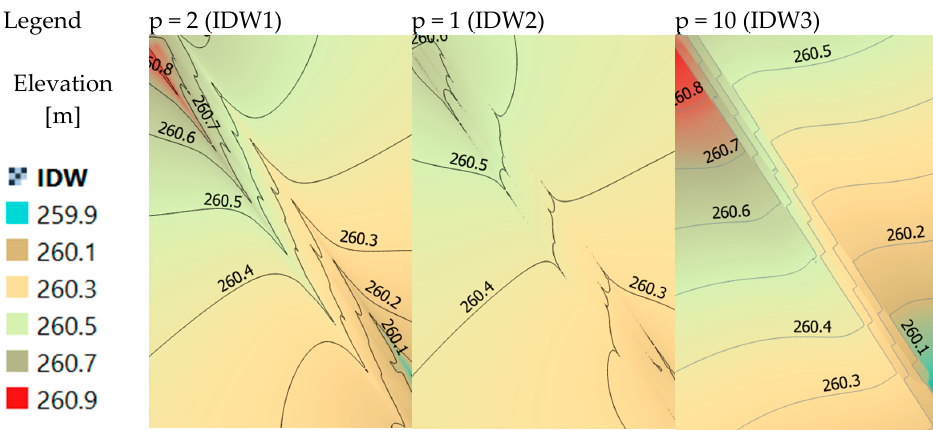
Figure 4. Results of IDW interpolation. Table 2. Results of IDW